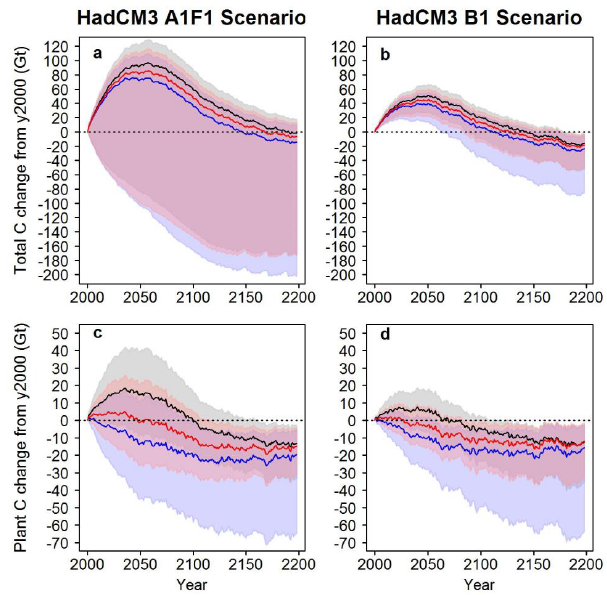
Fig. 9. Projected changes in terrestrial carbon under two climate change scenarios. These highlight the potential importance of pa- rameter and structural uncertainty. Lines and shading represent the average median, 5th and 95th percentile projected changes (rep- resenting parameter uncertainty) from the terrestrial carbon model using parameter probability distributions inferred from 10 training data subsets. Red, grey and blue correspond to different climate de- pendences for plant mortality, representing the major structural un- certainty in the model (see Fig. 1). Details of how we simulated the model are given in Appendix C. The additional code necessary to run these simulations is available at research.microsoft.com/en- us/downloads/, and the resulting simulation data are available from http://research.microsoft.com/en-us/downloads/49ad471e-7411-4f65-910a-